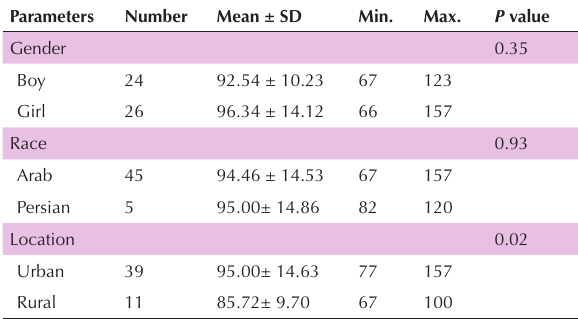
Table 2. The level of IQ in patients with SCD regarding gender, place of residence